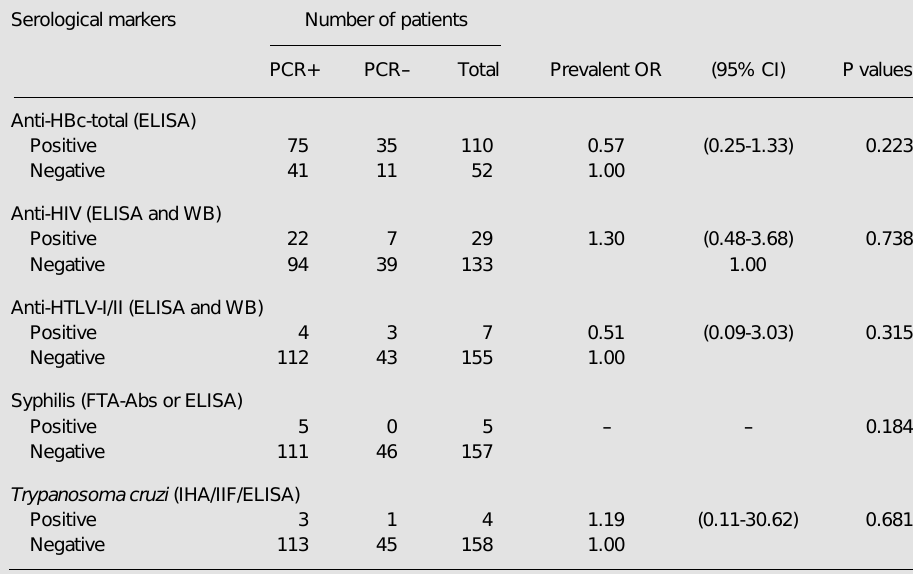
Table 2. Univariate analysis of positive anti-hepatitis C virus (HCV) hemophiliacs by their serological markers for other blood-borne infections and positivity of HCV-nested-RT-PCR. Serological